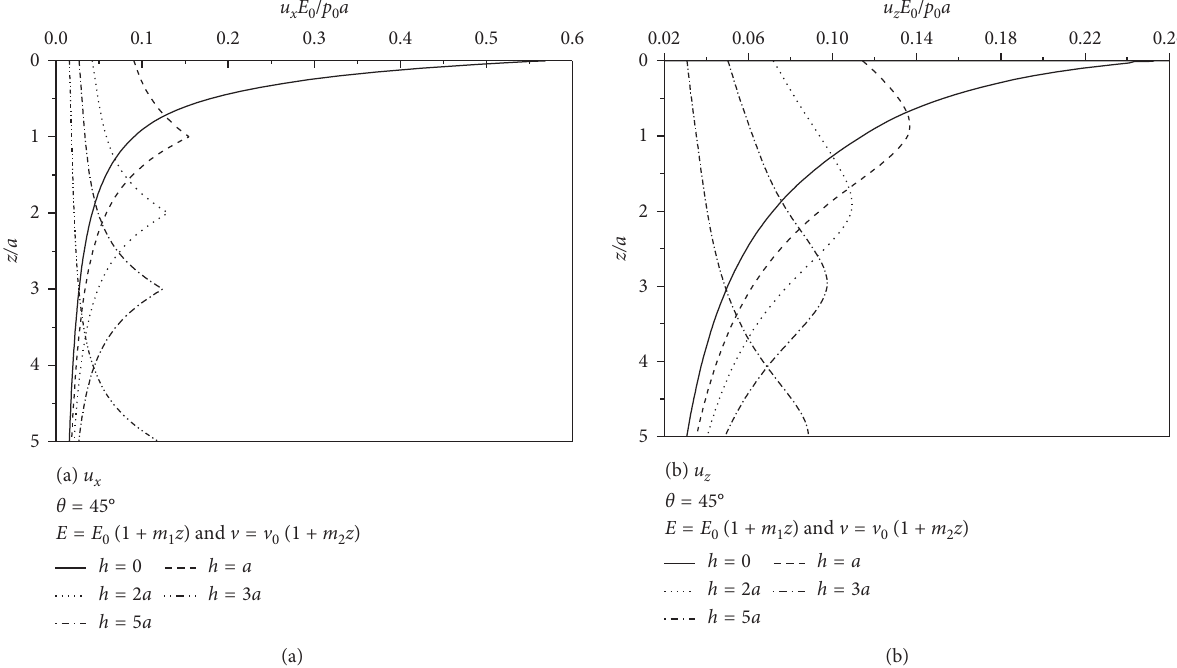
Figure 9: Variations of the displacements u